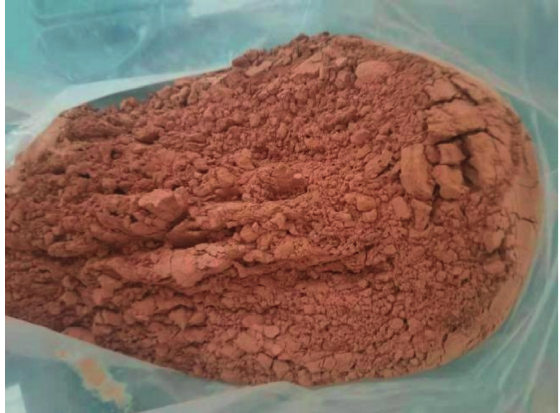
Figure 2: Recycled brick